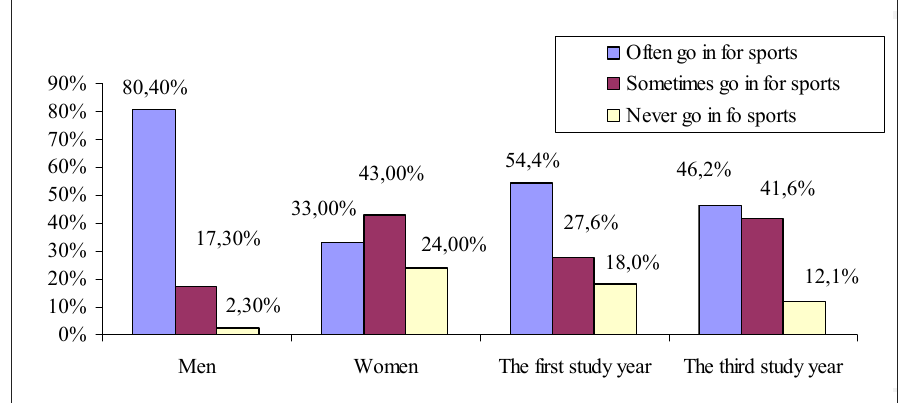
Fig. 2. Distribution of physical